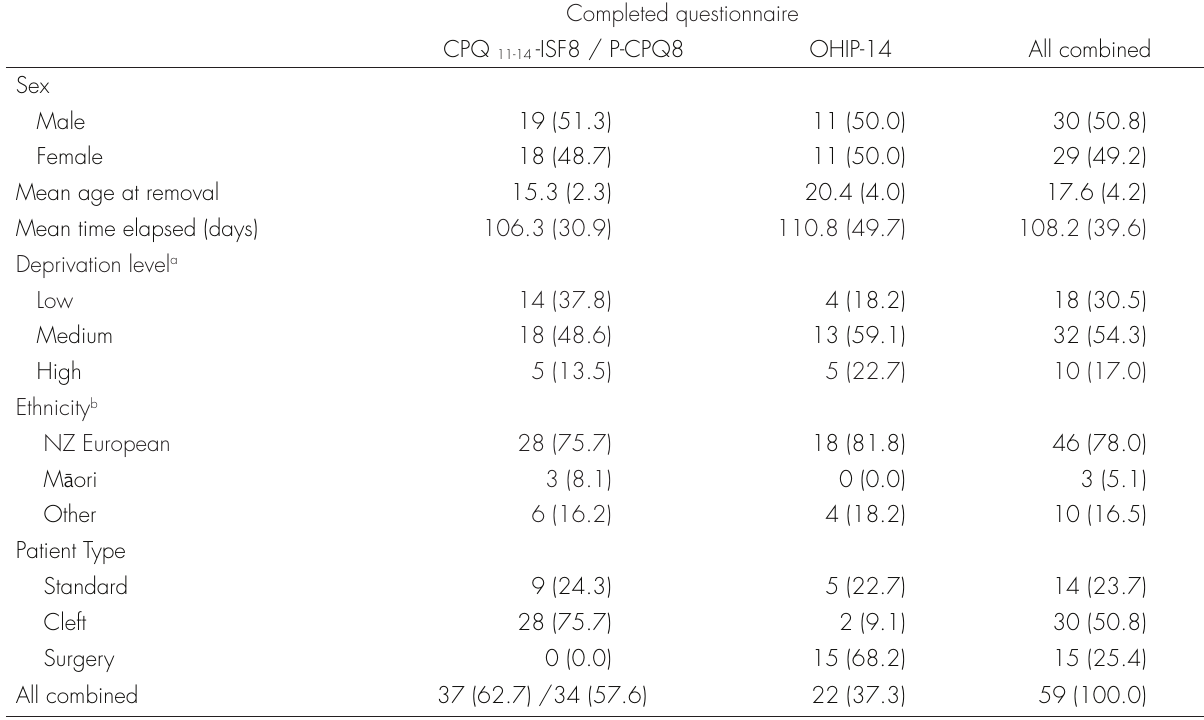
Table I. Baseline numbers at time of removal by sociodemographic characteristics of subjects (brackets contain percentages, unless otherwise specified).